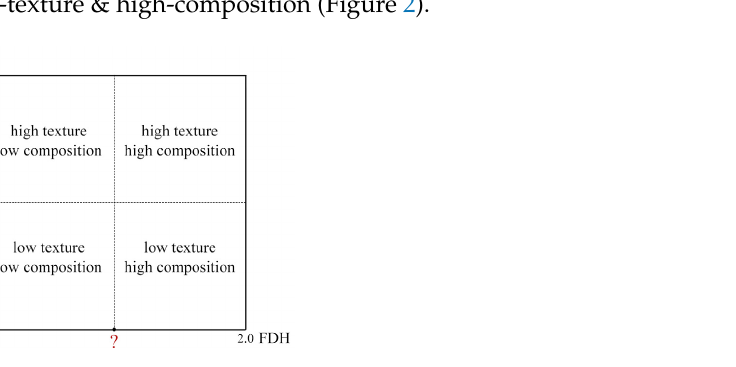
Figure 2. A rough classification of four scenarios based on FDT-FDH system.